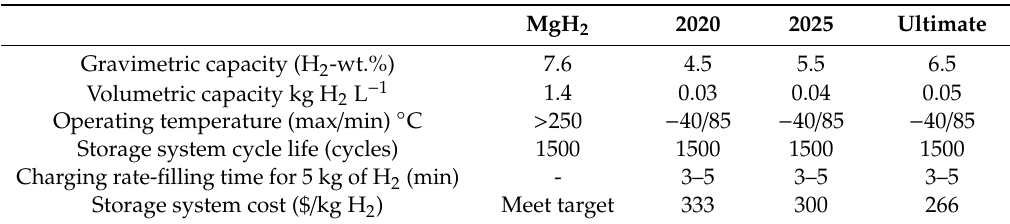
Table 1. U.S. Department of Energy (DOE) target requirements for on-board hydrogen storage systems versus Mg / MgH 2 storage properties, adapted from